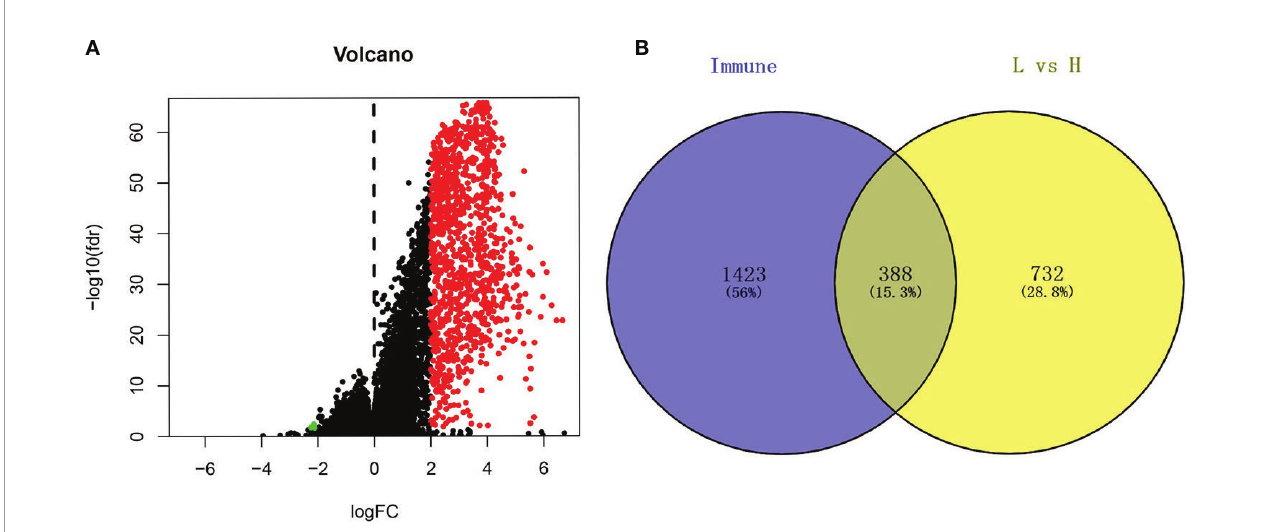
FIGURE 2 | Analysis of differentially expressed genes. (A) The volcano graph shows the distribution of differential genes between high immune cell in fi ltration cluster and low immune cell in fi ltration cluster, red dots represent up-regulated genes, green dots represent down-regulated genes. (B) Using the Venn diagram to extract intersection points, we obtained a total of 388 differentially expressed